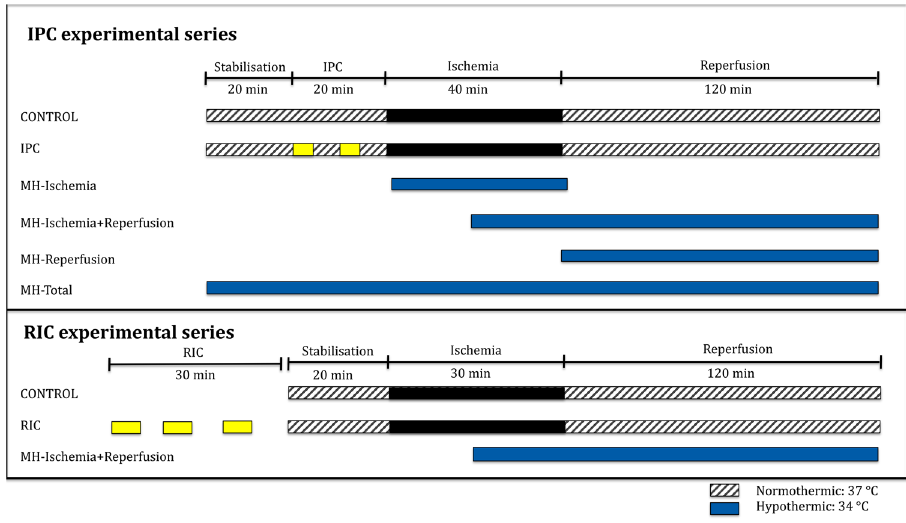
Figure 1. Study design. CONTROL control, IPC ischemic preconditioning, RIC remote ischemic preconditioning, MH-Ischemia mild hypothermia during ischemia, MH-Ischemia + Reperfusion mild hypothermia during last 20 min of ischemia and throughout reperfusion, MH-Reperfusion mild hypothermia during reperfusion only, MH-Total mild hypothermia through the total